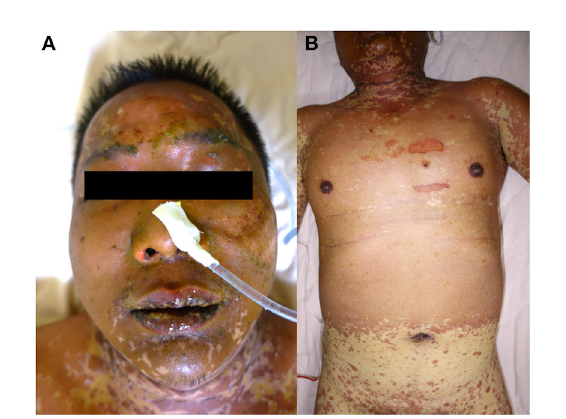
FIGURE1 Skin manifestations of a 42-year-old male. (A) Diffused erosions covered by crusts on the lips. (B) The erythematous vesiculobullous rash had spread to the entire body, along with epidermal